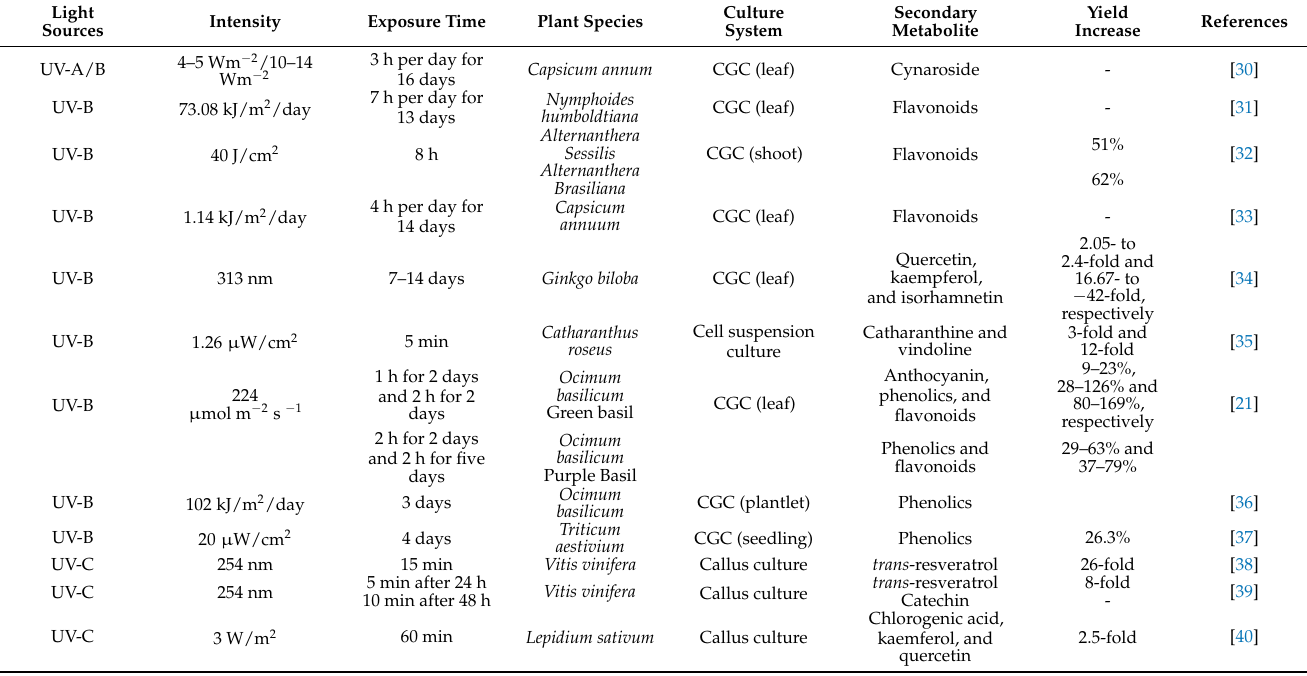
Table 1. Effects of UV light as an elicitor of key secondary metabolites in controlled and in vitro plant culture systems. Light